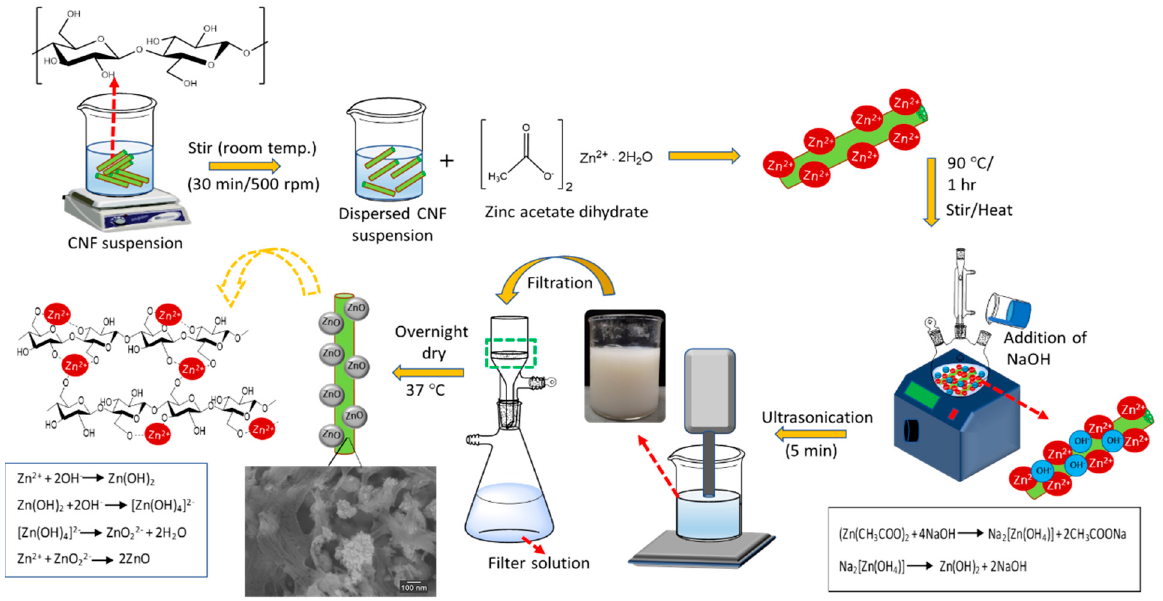
Figure 1. Sonochemical preparation of the cellulose nanofiber-zinc oxide (CNF-ZnO) nanocomposite.